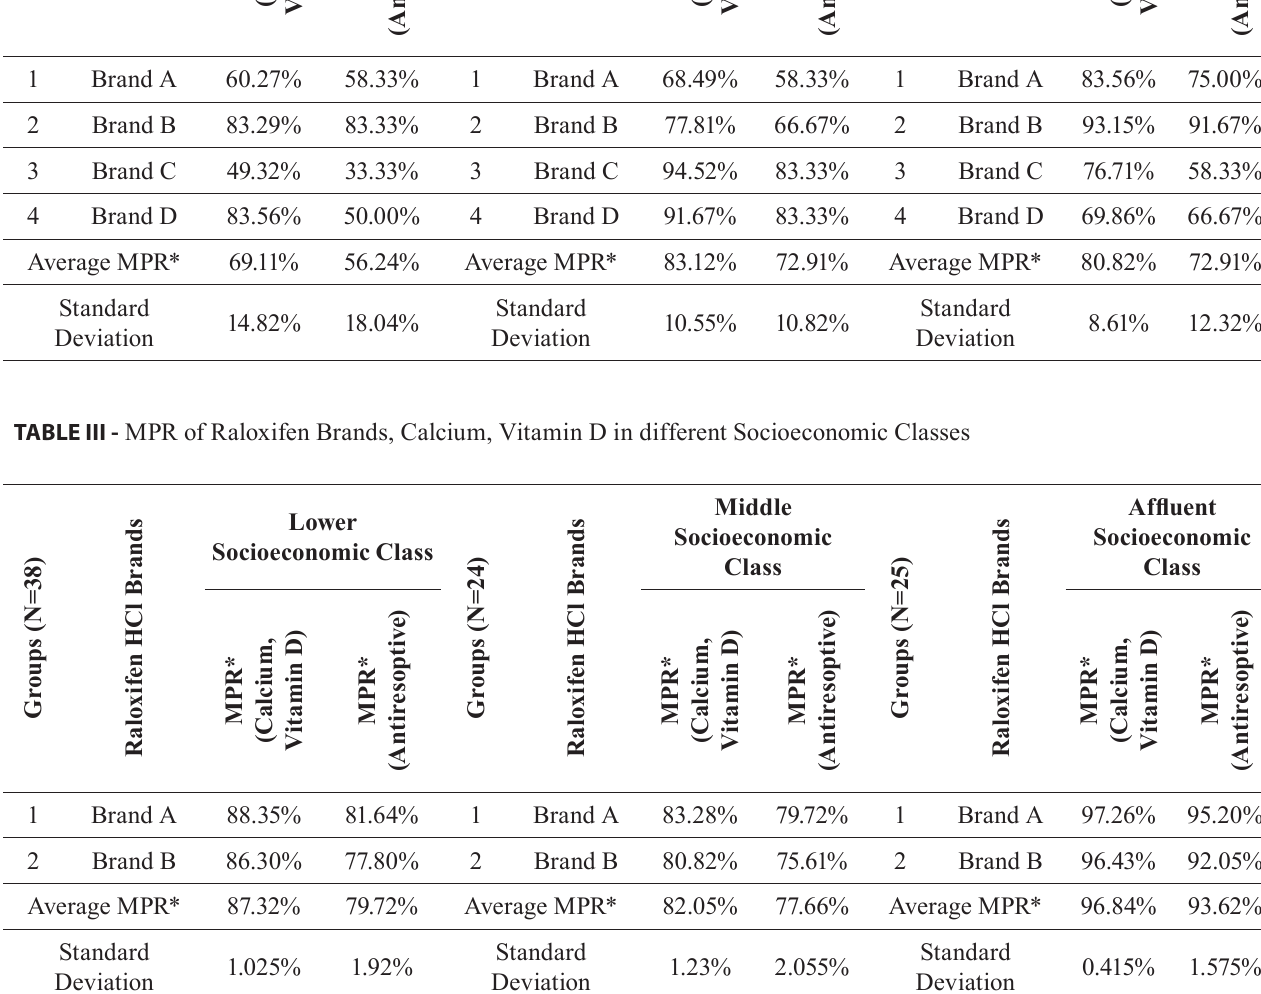
38 ) = N ( up s o r G